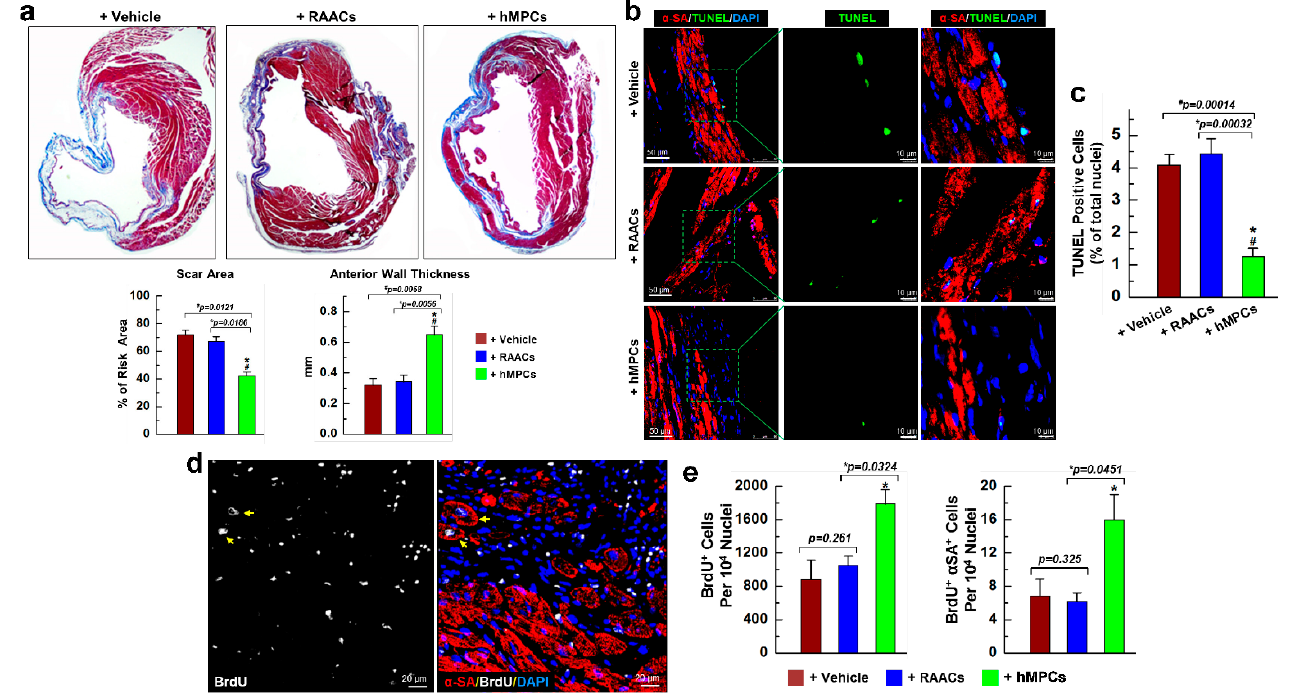
Figure 5. Transplantation of hMPCs reduces the infarct size and cardiac cell apoptosis and promotes endogenous cardiac regeneration. ( a ) Representative images of heart section with Masson’s trichrome staining and the quantitative analysis for the percentage of scar area over the risk area of the left ventricle, as well as the anterior wall thickness of left ventricle. ( b ) Representative confocal images for the staining of terminal deoxynucleotidyl transferase dUTP nick-end labeling (TUNEL) in risk area of infarcted mouse hearts. Green indicates the TUNEL-positive cells, red indicates the α SA-positive cells, and blue indicates the DAPI-positive nuclei. ( c ) Quantitative results for TUNEL + cells. The y-axis represents the percentage of TUNEL + cells over total nuclei. ( d ) Representative confocal images for heart section with BrdU and α -sarcomeric actinin staining. White color indicates the BrdU-positive proliferating cells, which are newly formed cardiac cells. Red color indicates the α -sarcomeric actinin ( α SA)-positive cardiomyocytes. Double-positive cells (BrdU + α SA + ) are newly formed or proliferated cardiomyocytes. ( e ) Quantitative results for BrdU + (left) and BrdU + α SA + (right). The y-axis stands for the number of BrdU + or BrdU + α SA + cells per 10 4 nuclei. Note: n = 6 mice per group, 20 images/slide; data are means ± SEM; * p < 0.05 versus Vehicle group, # p < 0.05 versus RAAC group, as calculated by one-way ANOVA followed by Tukey’s multiple comparison